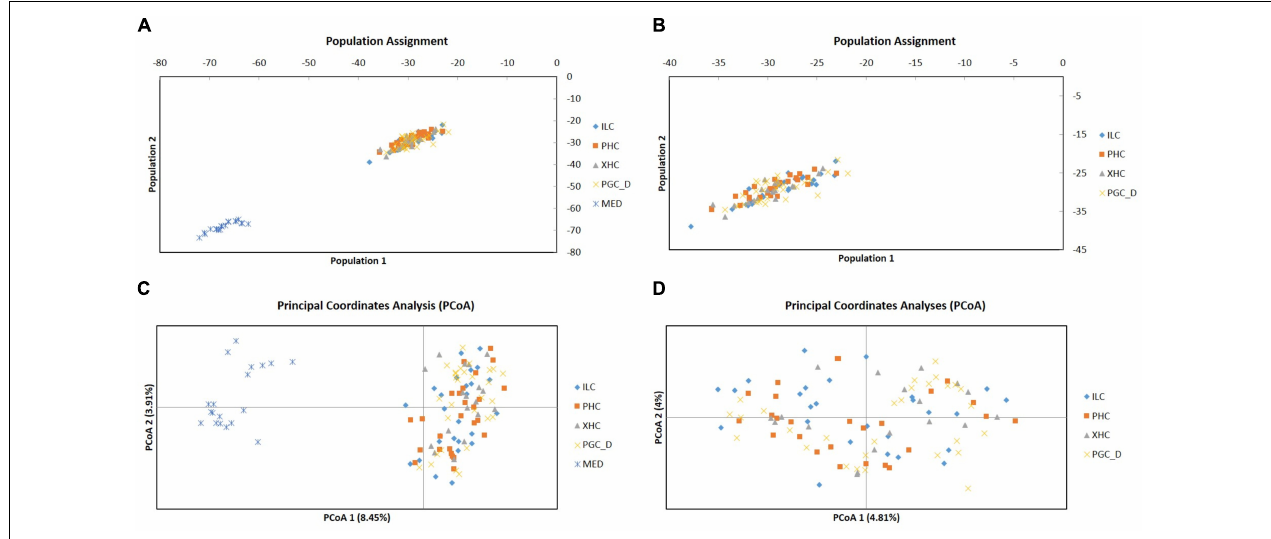
FIGURE 3 | Population assignment (A,B) and genetic distance (C,D) among D. dianthus individuals from each sampling locality, including (A,C) or excluding (B,D) individuals from Mediterranean Sea (MED). For complete locality names (see Figure 1 ). MED,